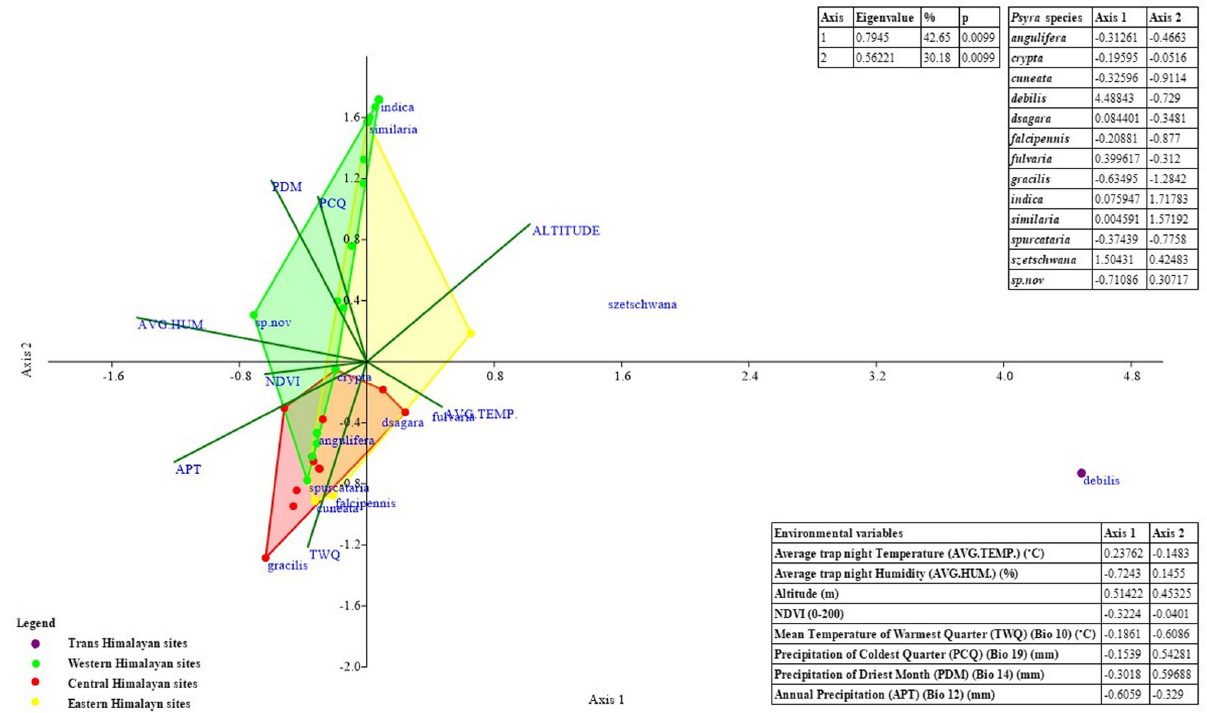
Fig 20. Canonical Correspondence Analysis (CCA) ordination plot of the Psyra species abundance against environmental predictors in 4 Himalayan zones (Trans, Western, Central & Eastern shown as coloured areas) sampled during 2010–2012 and 2016–2019. The green lines represent the extent of each environmental predictors (shown in CAPITAL) while the coloured points represent sites sampled in respective Himalayan zones. Percentage variation explained by each axis, intraset correlations between individual species, environmental predictors and ordination axes are shown in inset